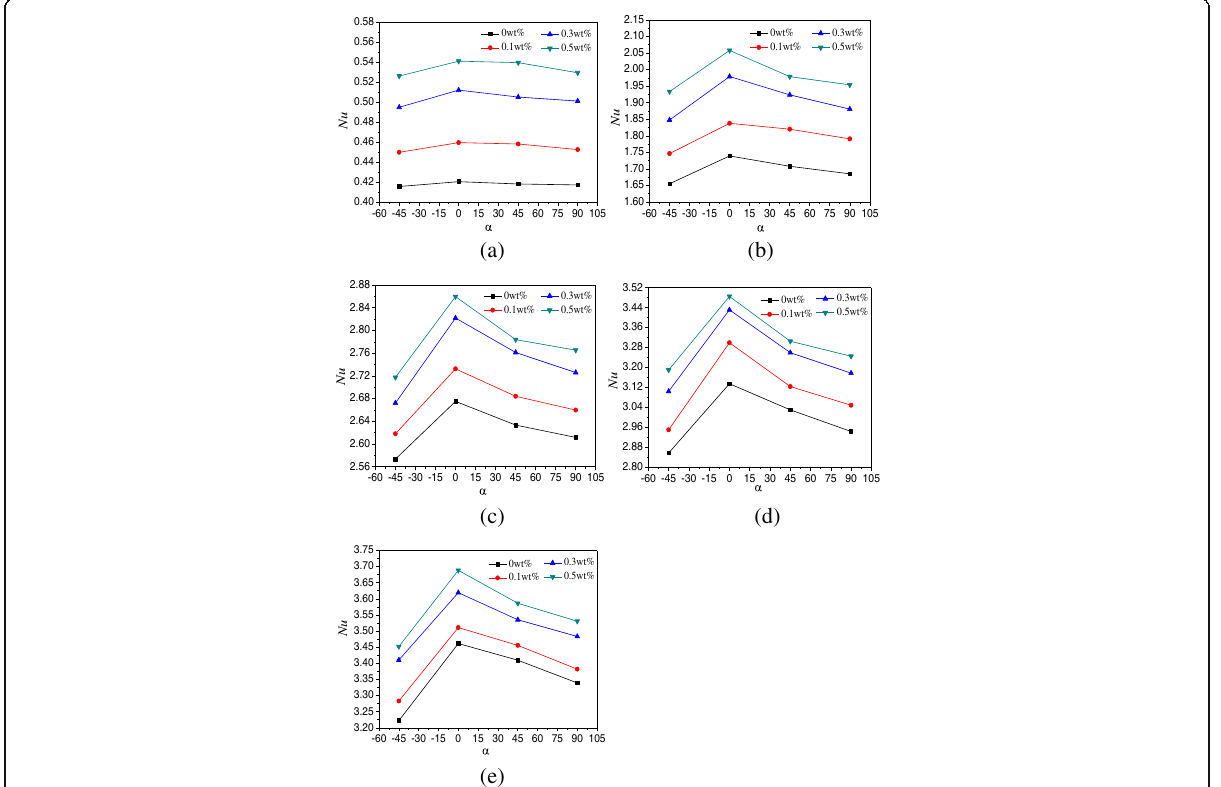
Fig. 8 Changes of Nusselt numbers with rotation angles ( A =1:2). Average Nusselt numbers change of nanofluid with rotation angles of enclosure ( A =1:2) at different heating powers. a Q =1 W. b Q =5 W. c Q =10 W. d Q =15 W. e Q =20